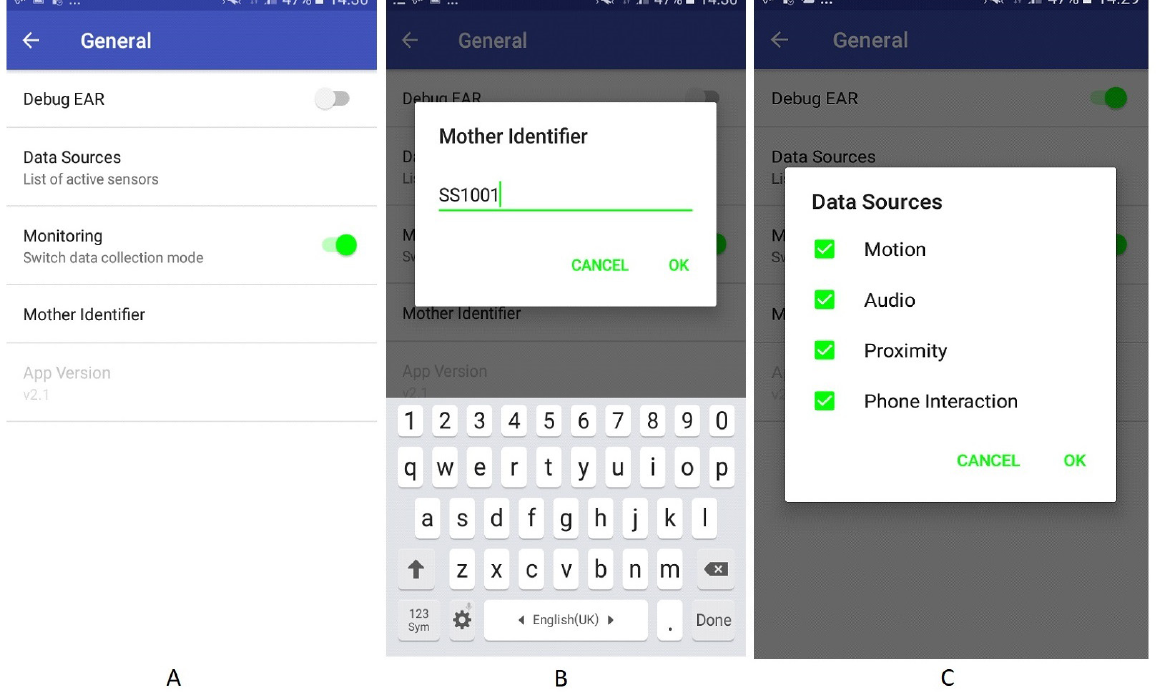
Figure 3. General tab ( A ), mother identifier ( B ), and passive data sources ( C ) while setting up the Electronic Behavior Monitoring